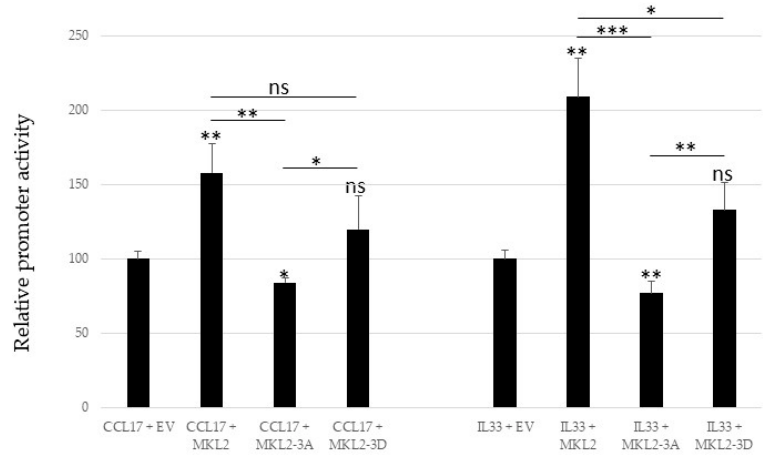
Figure 8. Mutations in the PKA phosphoaccpetor sites of MKL2 LTag affect transactivation of the CCL17 and IL33 promoters. Cells were co-transfected with a luciferase reporter plasmid containing the sequences − 2535/+40 of the CCL17 promoter or − 1050/+45 of the IL33 promoter, and empty expression vector (EV) or expression vector for MKL2, MKL2-3A, or MKL2-3D LTag. The bars represent the average of three independent parallels ± SD. The statistically significant difference between promoter activity in the presence of EV and MKL2 (respectively MKL2-3A and MKL2-3D) is shown on top of the bars, whereas differences between MKL2 and the mutants and between MKL2-3A and MKL2-3D are given on top of the lines. * p < 0.05, ** p < 0.01, and *** p < 0.001, ns = not significant.